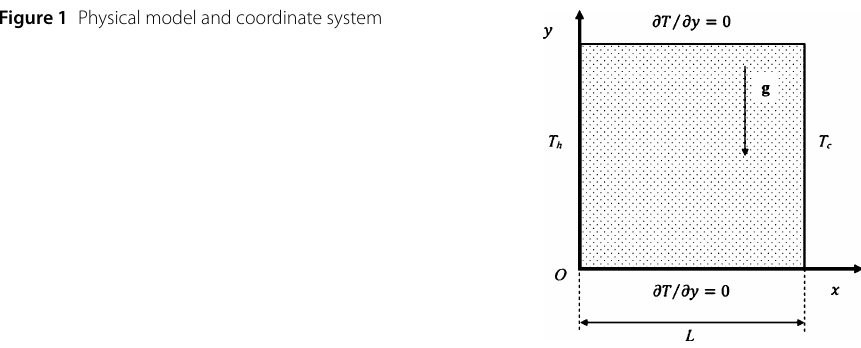
Figure 1 Physical model and coordinate